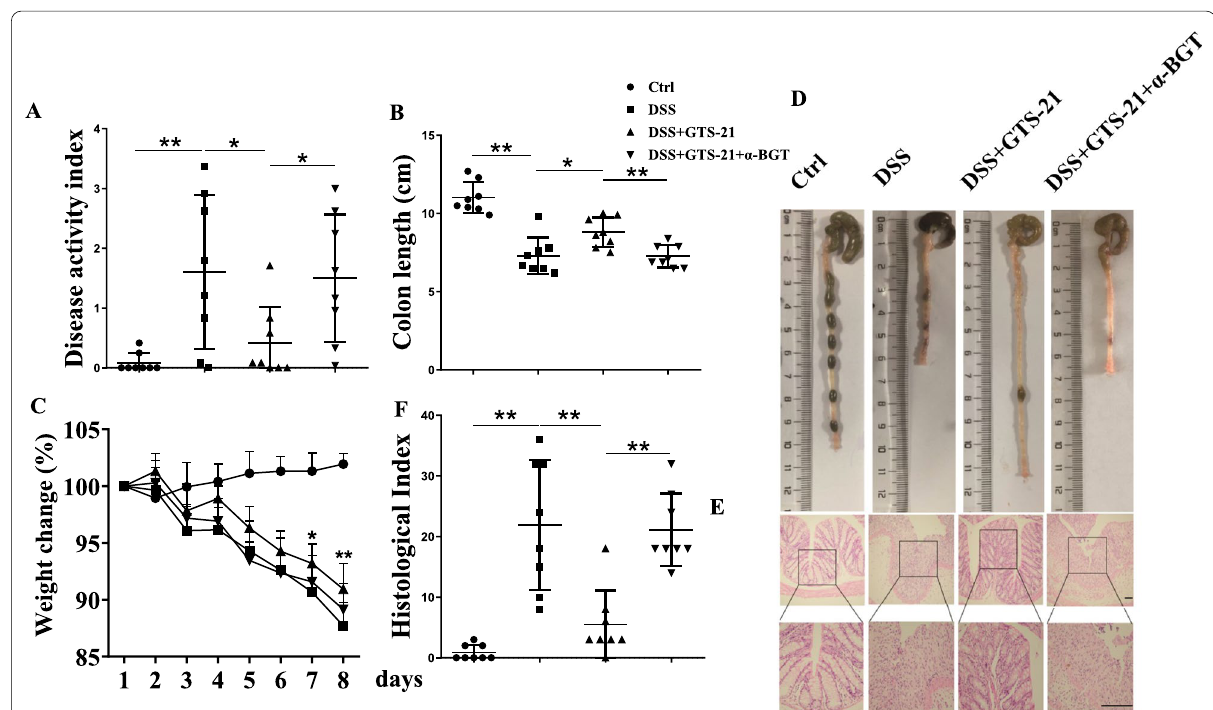
Fig. 1 α7nAChR agonist GTS-21 treatment attenuates dextran sodium sulphate (DSS)-induced colitis. A Disease activity index (DAI) scores on day 8 was evaluated. * p < 0.05; ** p < 0.01. B Colon length on day 8. * p < 0.05; ** p < 0.01. C Weight change (%) from day 0 to day 8. * p < 0.05; ** p < 0.01(GTS-21 DSS vs. DSS alone). D Gross macroscopic inflammation and length of the large bowel in each group. E Hematoxylin and eosin + (H&E) was performed on paraffin-embedded distal colon tissue. Magnification: upper panels, ** p < 0.01. All data represent as mean SEM of 8 mice per group. Scale bar, 500 ±